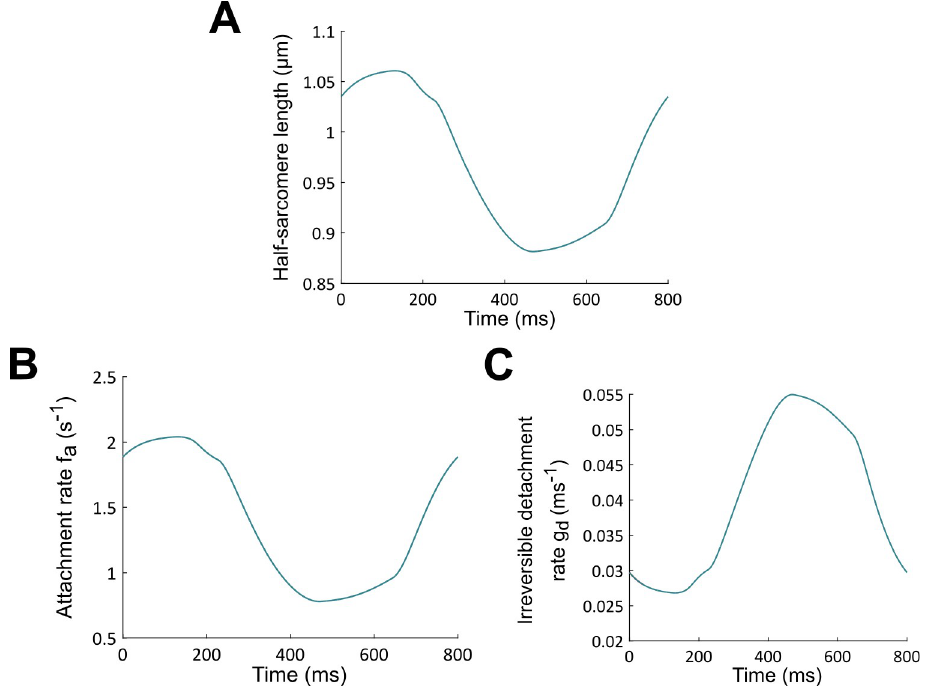
Fig 6. Half-sarcomere length L during a baseline heartbeat (normal hemodynamics conditions) (A). Associated BL attachment rate f (B) and irreversible detachment rate g d (C). These rates are used as input functions for the NO LDA model, in such a way that panels B and C also correspond to the attachment rate f and irreversible detachment rate g for the NO LDA case.